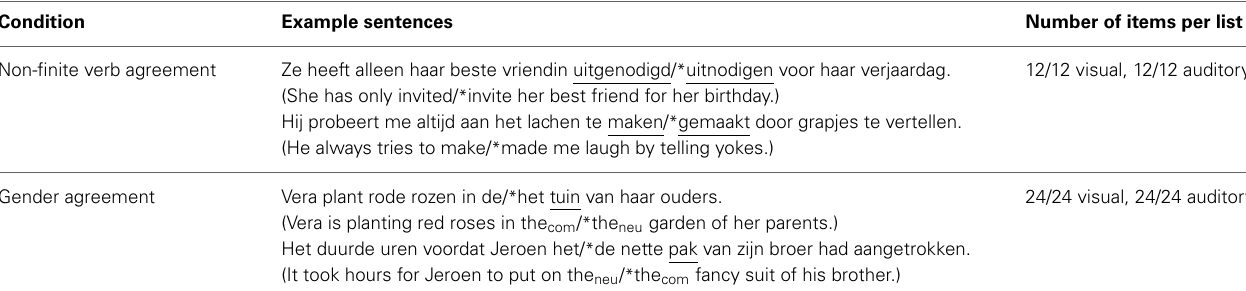
Table 2 | Example materials of the EEG experiment.